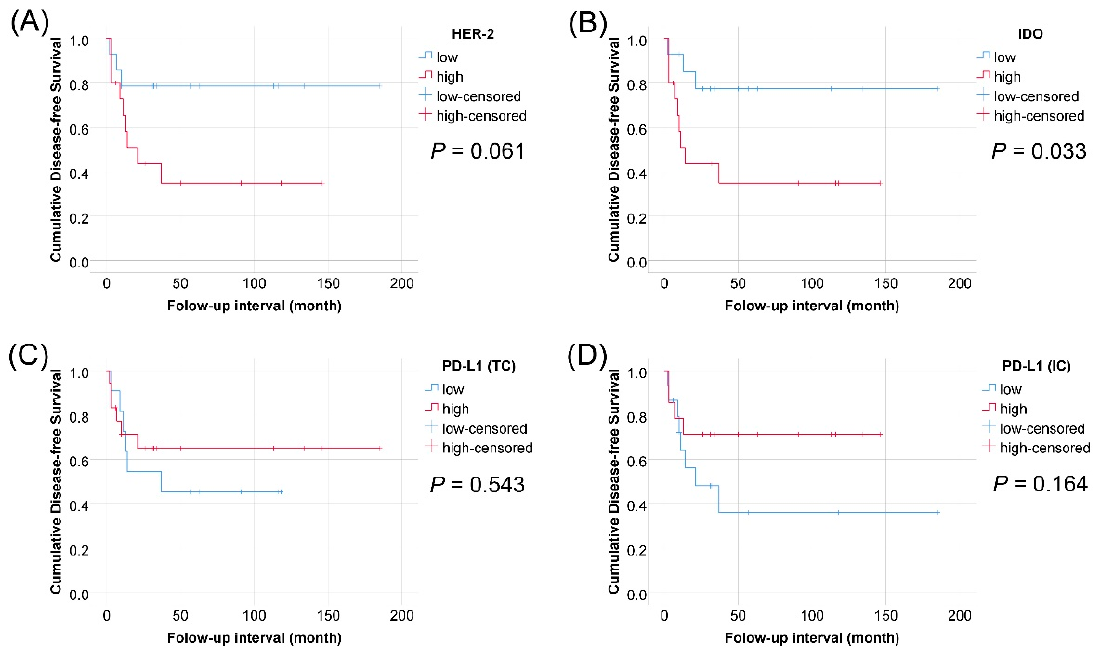
Figure 4. Kaplan–Meier survival curves of disease-free survival in 29 cases with post-operative radiotherapy among 69 patients of pathologic tumor stage pT2–pT4 urothelial carcinoma of the bladder, according to expression of HER2 in tumor cells, IDO in tumor cells, PD-L1 in tumor cells, and PD-L1 in immune cells. ( A ) HER2; ( B ) IDO; ( C ) PD-L1 (TCs); ( D ) PD-L1 (ICs)).